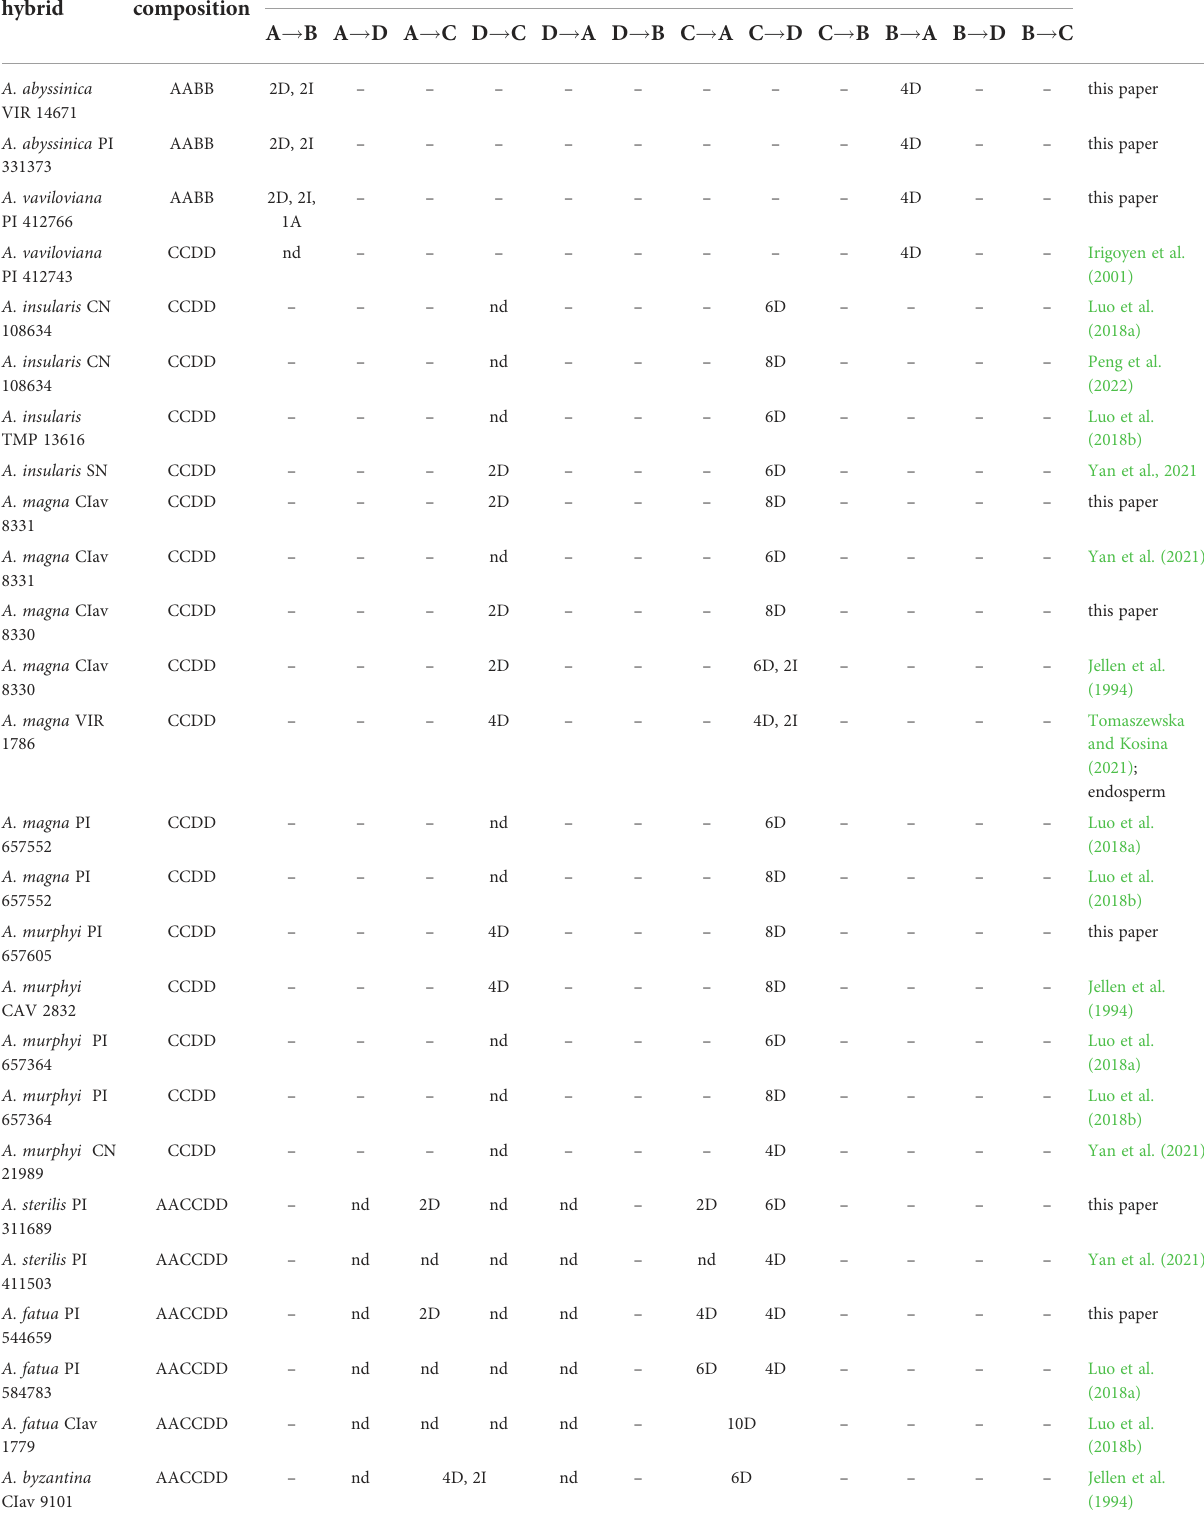
TABLE 2 Pattern of intergenomic translocations across different oat taxa. Species/